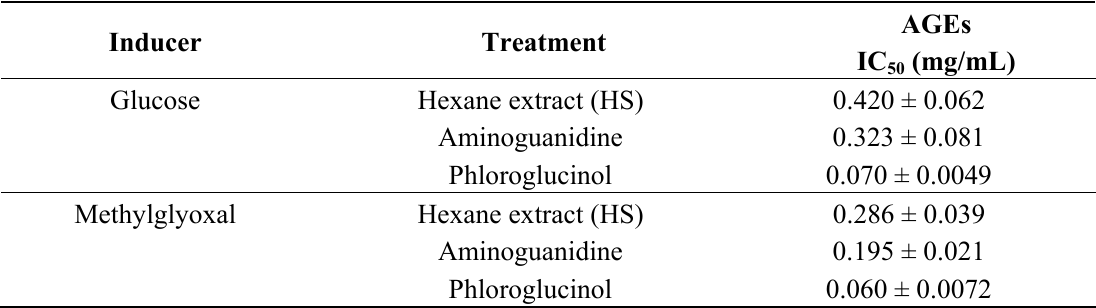
Table 3. Inhibitory effects of hexane extract from Piper auritum (HS) and aminoguanidine on the formation of advanced glycation end products (AGEs), in vitro induced byglucose and